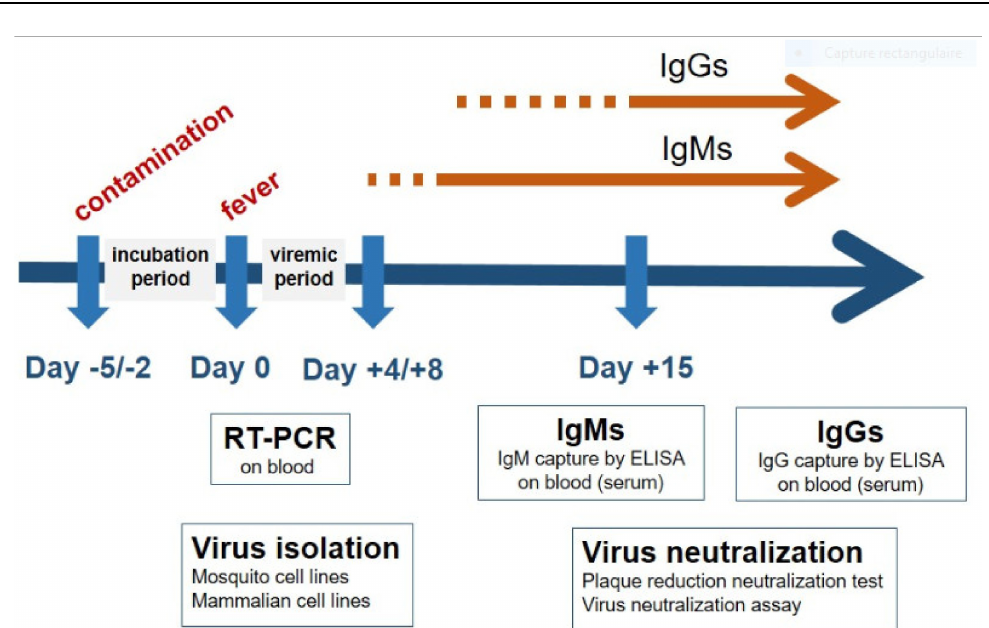
Figure 1. Flow chart of molecular and serological diagnosis tests in the course of human flavivirus